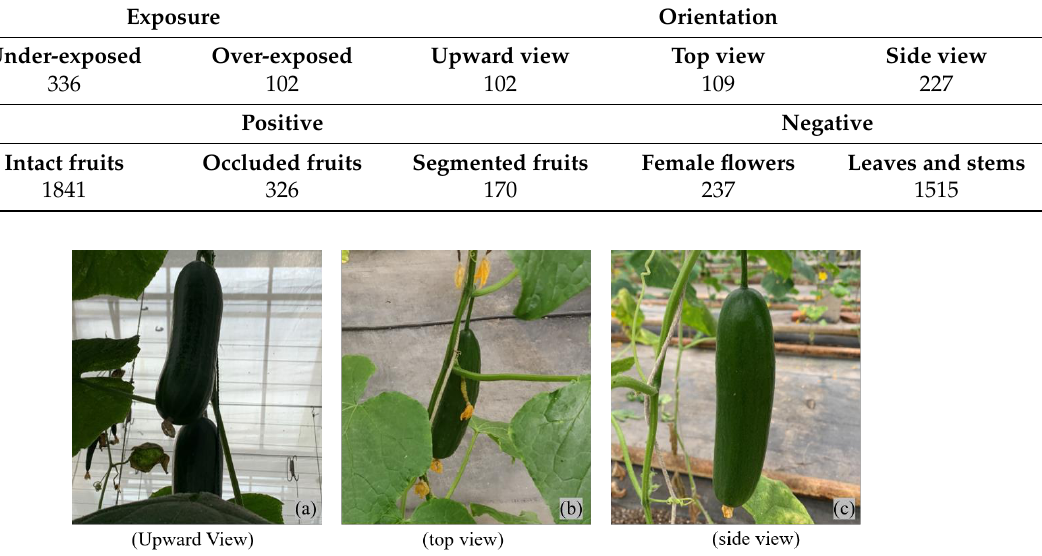
Figure 1. Upward view ( a) , top view ( b ), and side view ( c ) of cucumbers obtained using different camera orientations.